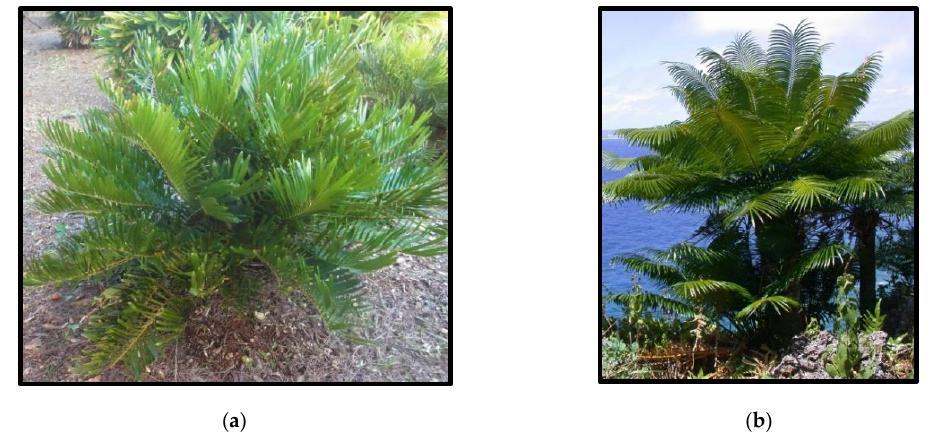
Figure 1. Two of the cycad species native to the United States: ( a ) the diminutive Zamia integrifolia ; ( b ) the arborescent Cycas micronesica .